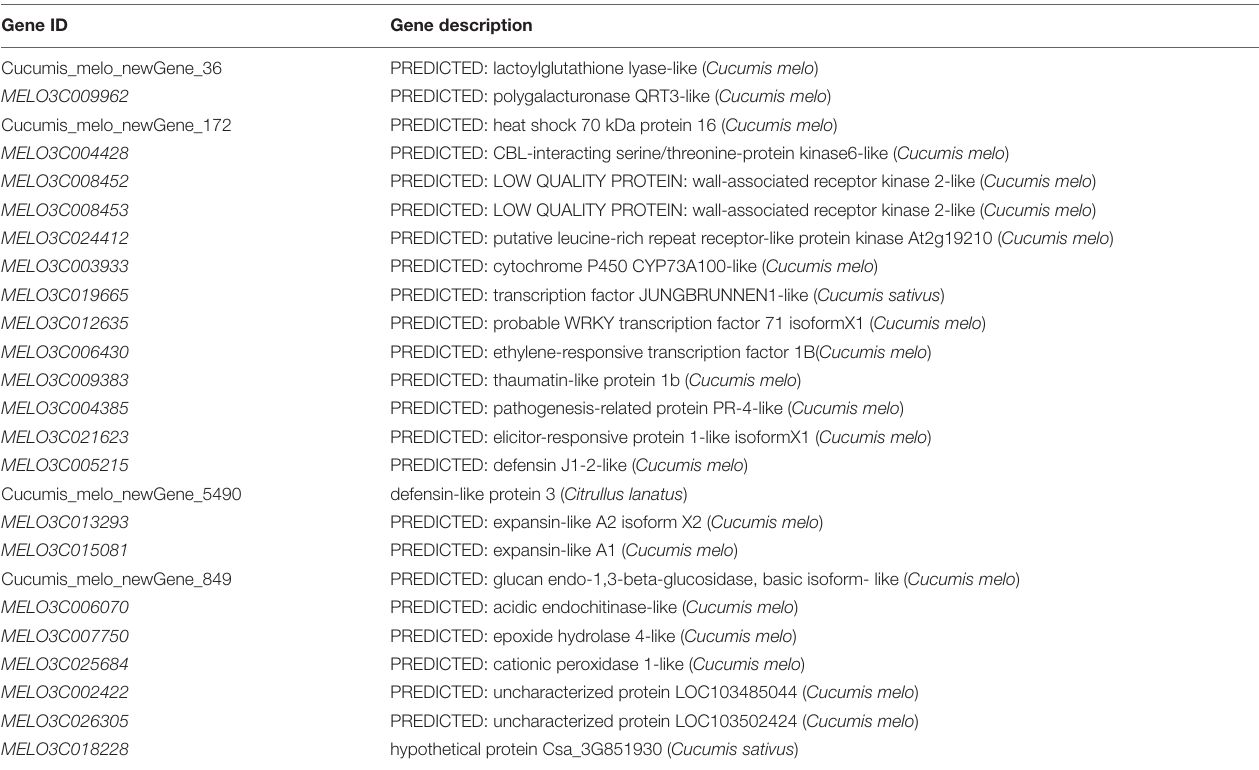
TABLE 1 | Identification of candidate DEGs in analyzed transcriptome data. Gene